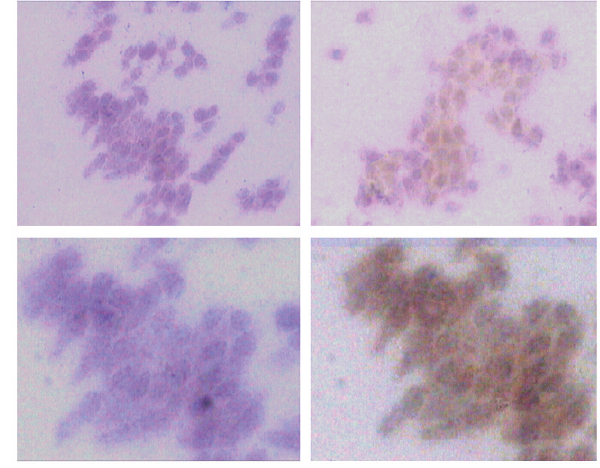
Figure 3 - IL-6 expression. Top images: on the left, the bimatoprost + timolol group pre-treatment, with cells negative for IL-6. On the right: the same group after treatment, with 200 6 magnification. The figures on the bottom show the same images as above, with 400 6 magnification. Note the increase in positive cells after treatment (images on the